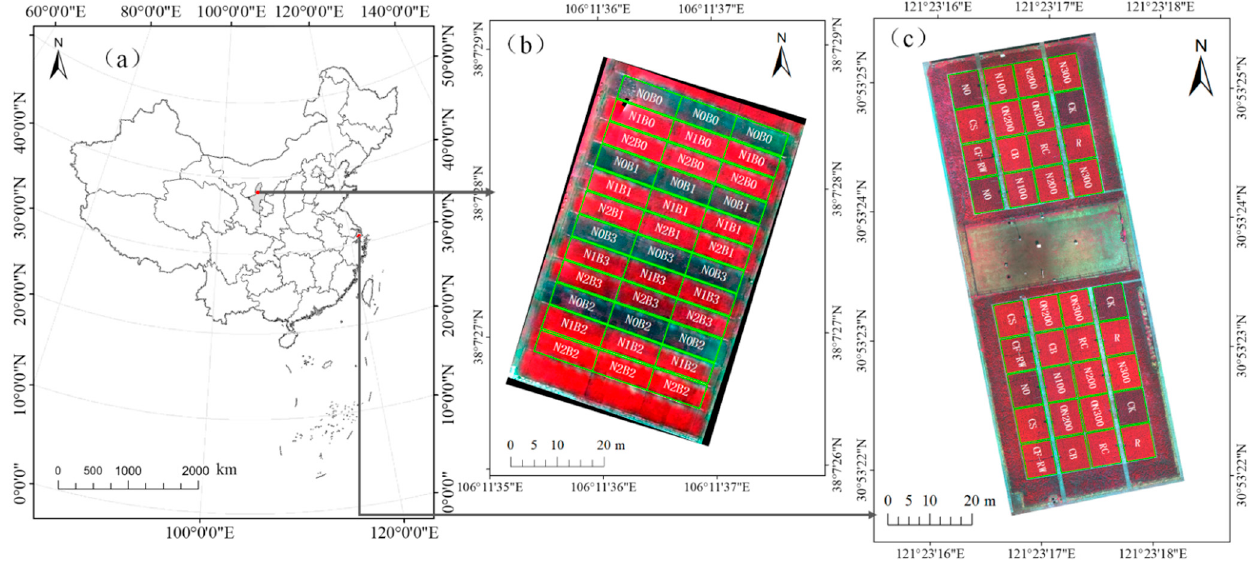
Figure 1. Location and UAV images of the two study areas: ( a ) Location of the two study areas, ( b ) UAV false color image of the rice plots in Ningxia, ( c ) UAV false color image of the rice plots in Shanghai.